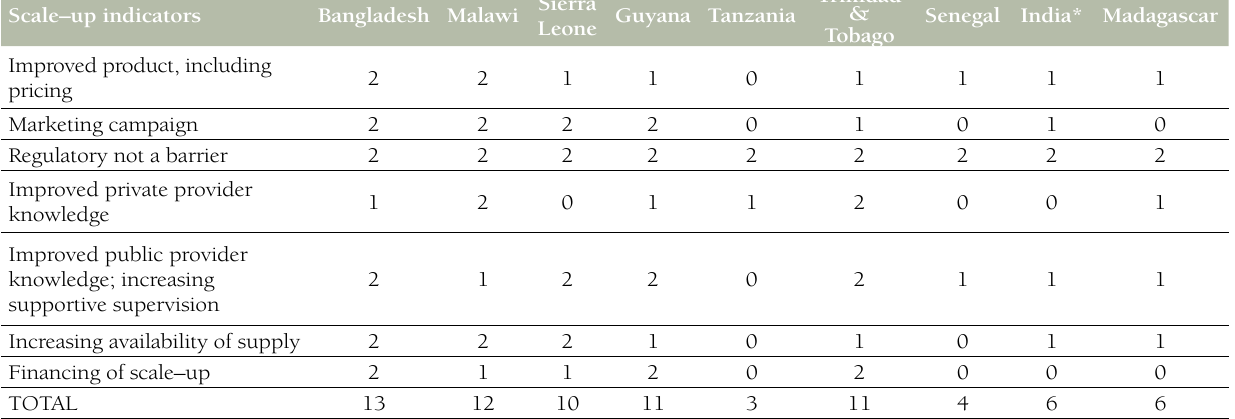
Table 6. Scores given to each country for each scale–up criterion Scale–up